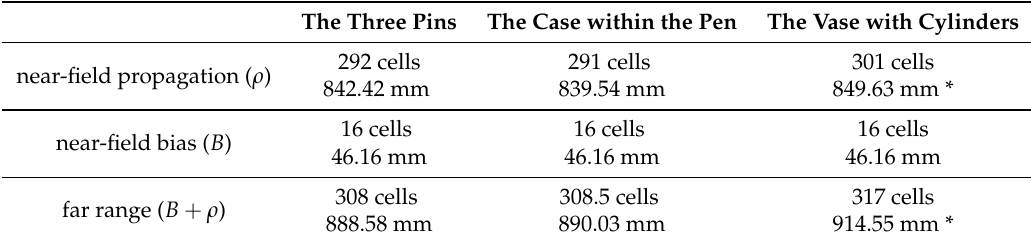
Table 1. Estimation results for the targets. (*: the distance is changed as antennas are moved). The Three Pins The Case within the Pen The Vase with